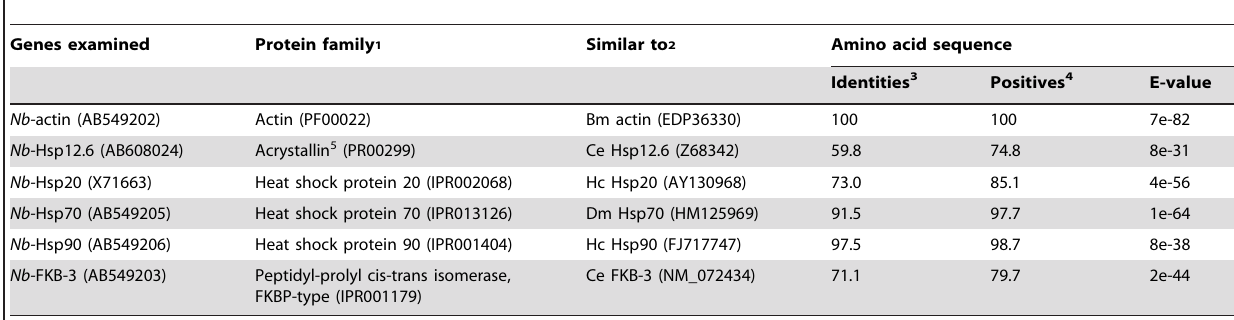
1 Protein family to which translated amino acid sequences of N. brasiliensis transcripts showed a ‘true’ match in the InterProScan sequence search. 2 The most similar sequence found by the BLAST search of the UniProt protein databases. Bm, Brugia malayi ; Ce, C. elegans ; Dm, Dracunculus medinensis ; Hc, Haemonchus contortus . 3 Percent sequence identity. 4